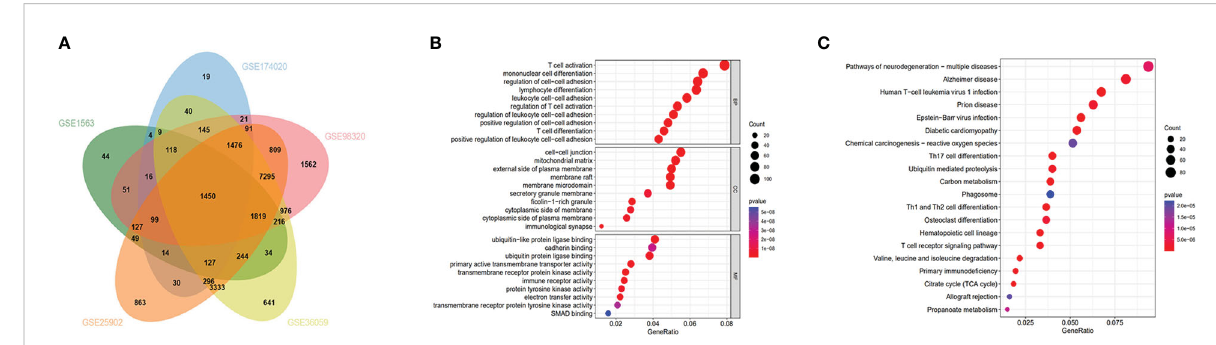
FIGURE 1 Functional enrichment analysis and Venn diagram of DEGs: (A) Venn diagram demonstrating DEGs in the 5 datasets (GSE1563, GSE174020, GSE98320, GSE36059, GSE25902). (B) GO analysis for DEGs. (C) KEGG analysis for